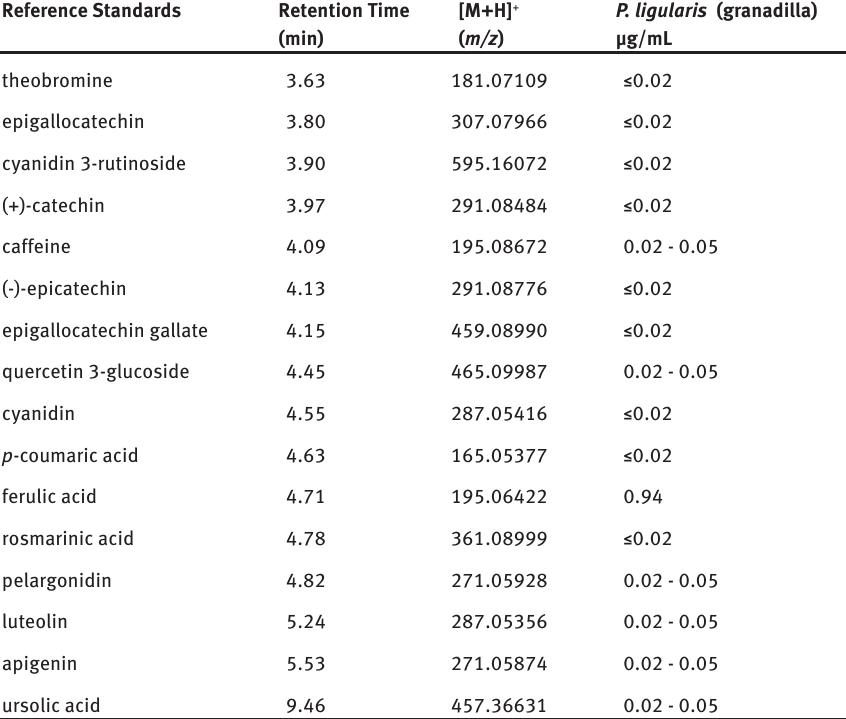
Table 1: Standard reference compounds, with their retention time and mass spectrum MS responses and concentrations for polyphenols in P. ligularis (granadilla) extract.